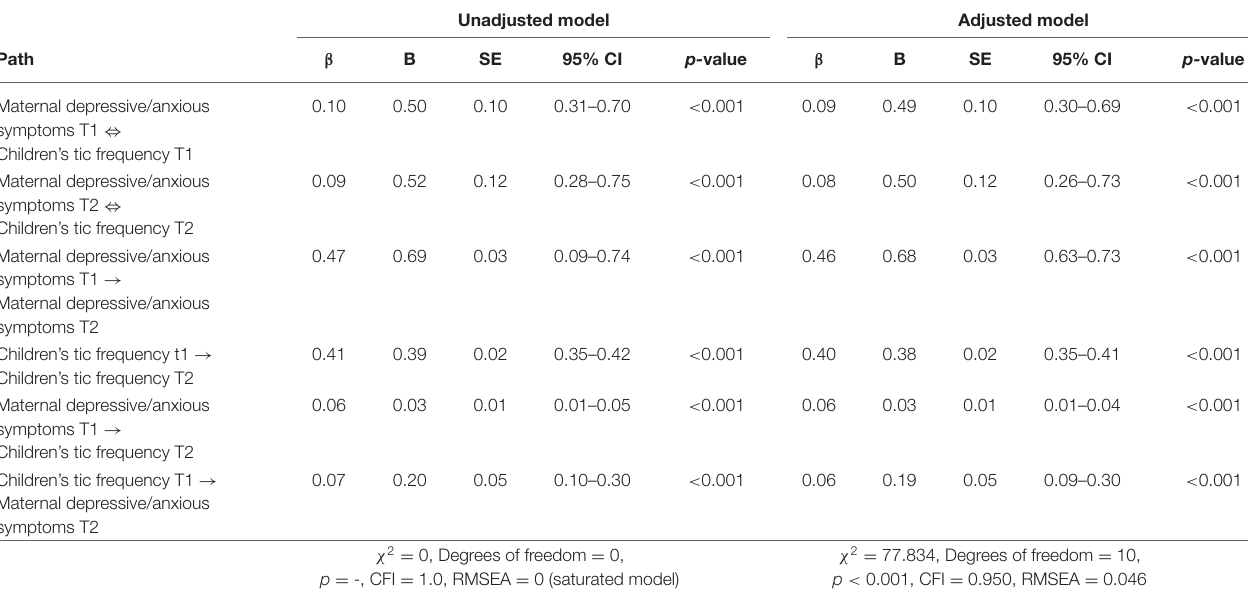
FIGURE 2 | Cross-lagged model of relationships between maternal depressive/anxious symptoms and children’s tic frequency. This figure shows the results of the adjusted model in Table 2 . Paths from covariates are omitted from the figure. e, error variable; T1, 10 years of age; T2, 12 years of age. *** p < 0.001. TABLE 2 | Relationships between maternal depressive/anxious symptoms and children’s tic frequency (n = 3,171). Unadjusted model Adjusted